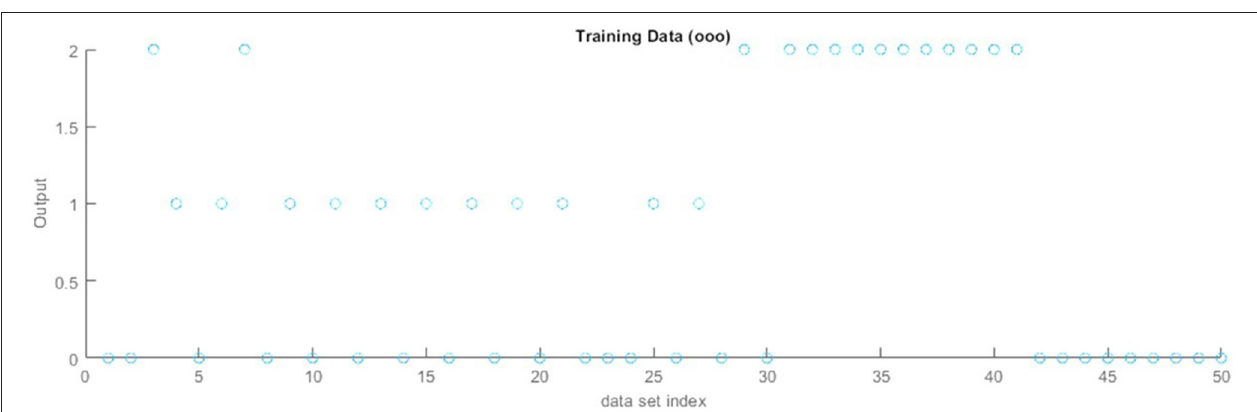
of rules are generated which leads toward the final output value, which indicates the type of intrusion attack. Figure 8 represents the training results of the KDDcup 99 datasets collected from the Kaggle website for network intrusion detection based on ANFIS. The training model contains five input values and generates a single output. The training model shows the increasing flow of accuracy